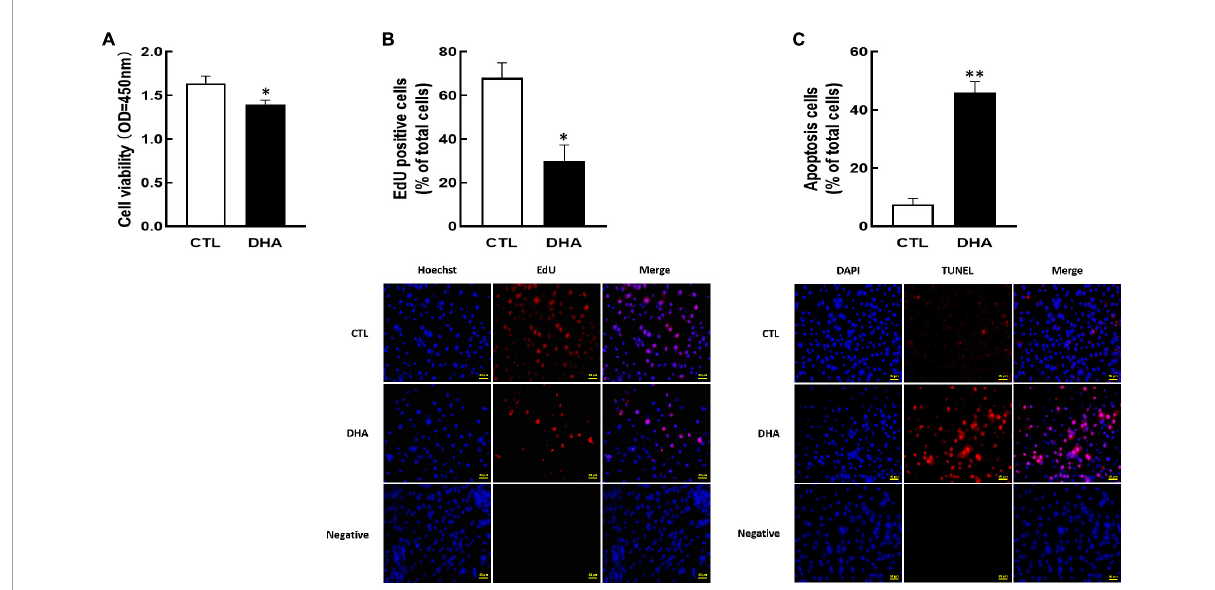
FIGURE1 Effect of Omega-3 on cellular development in KGN cells. The cells were cultured for 24 h in the absence or presence of omega-3 (25 µ M), and then cell viability (A) , proliferation (B) and apoptosis (C) were detected by CCK-8 assay, EdU and TUNEL measurement, respectively. Data are presented as mean ± SEM of three independent experiments. ∗ P < 0.05, ∗∗ P < 0.01 compared with control (CTL). Bar = 50 µ m.